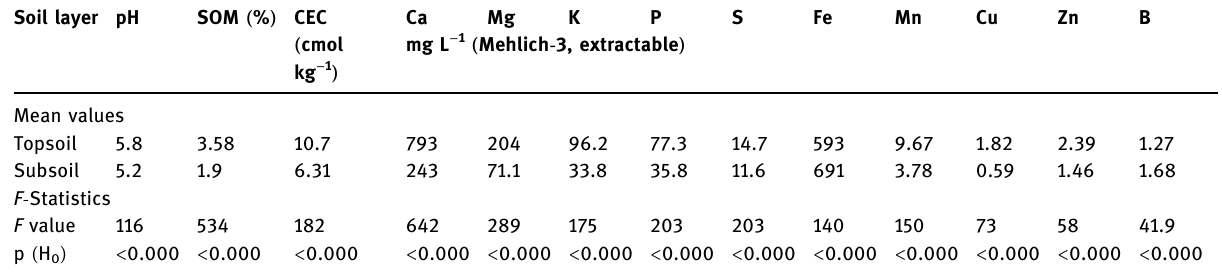
Table 3: E ff ect of soil depth on soil parameters. Topsoil and subsoil data from all 3 years were included in the analysis Soil layer